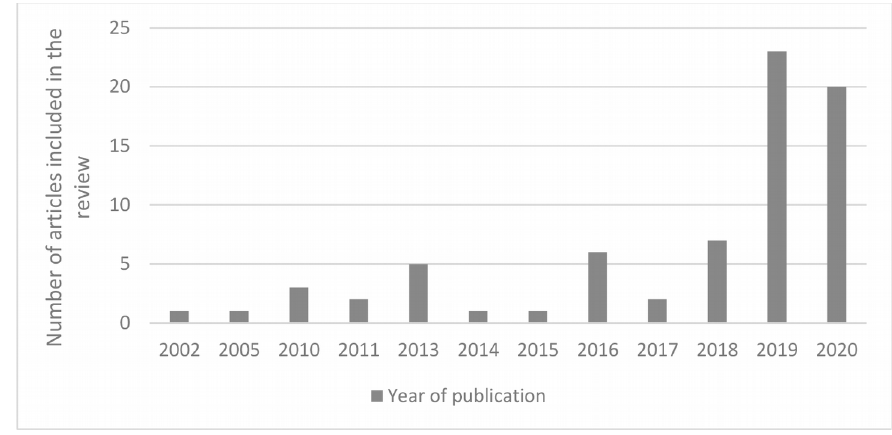
Figure 1. Distribution of papers by year of